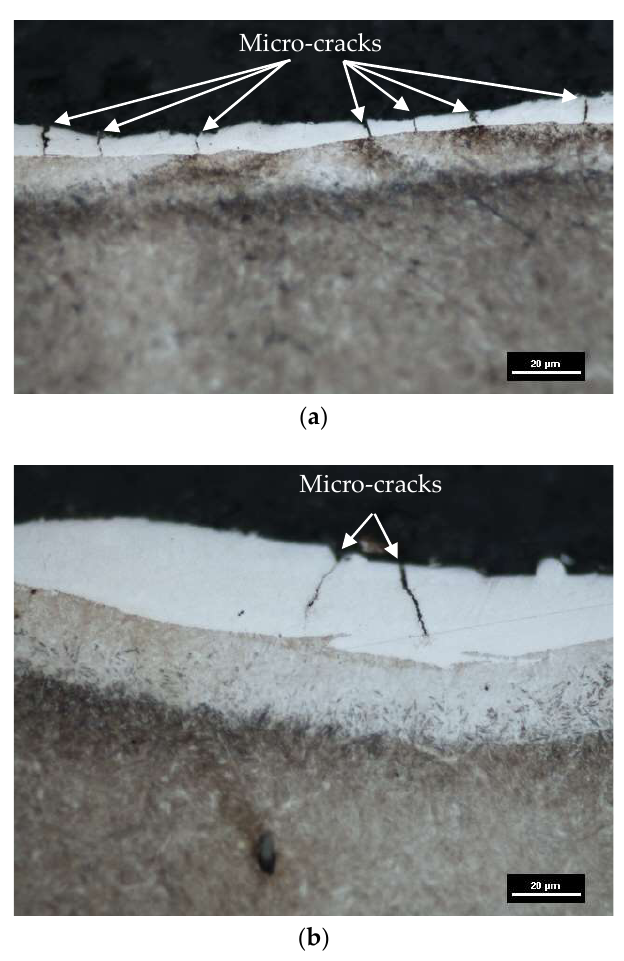
Figure 8. The metallographic structure of tool steel 55NiCrMoV7 after EMD: ( a ) Uc = 25 V, I = 3 A, t on = 206 μs, t off = 80 μs; ( b ) Uc = 25 V, I = 14 A, t on = 400 μs, t off = 80 μs.